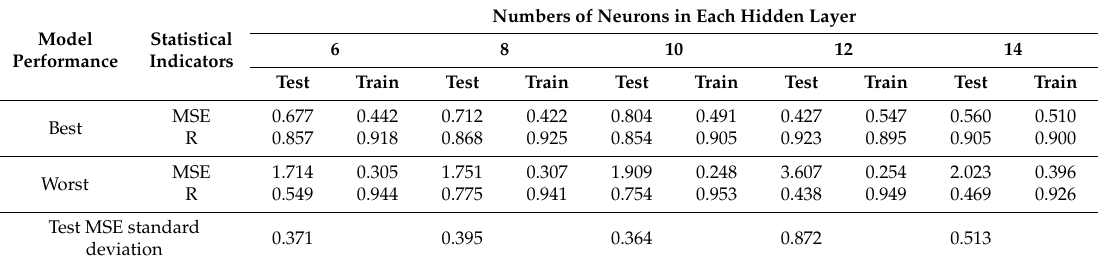
Table 8. E ff ect of data sample variability on the Marshall stability model’s performance.